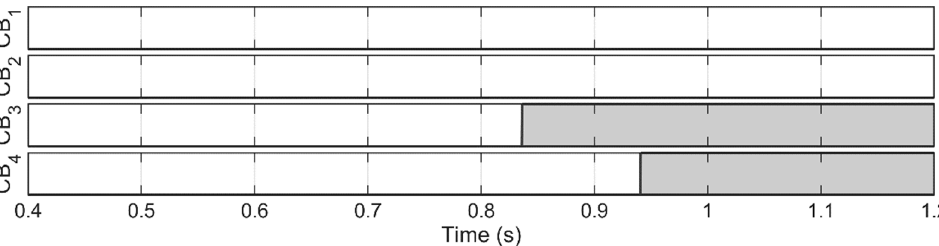
Figure 19. Currents in HTS cables in case DCR fails: ( a ) HTS 1 ; ( b ) HTS 2 . Figure 20. Conducted power in HTS cables in case DCR fails.